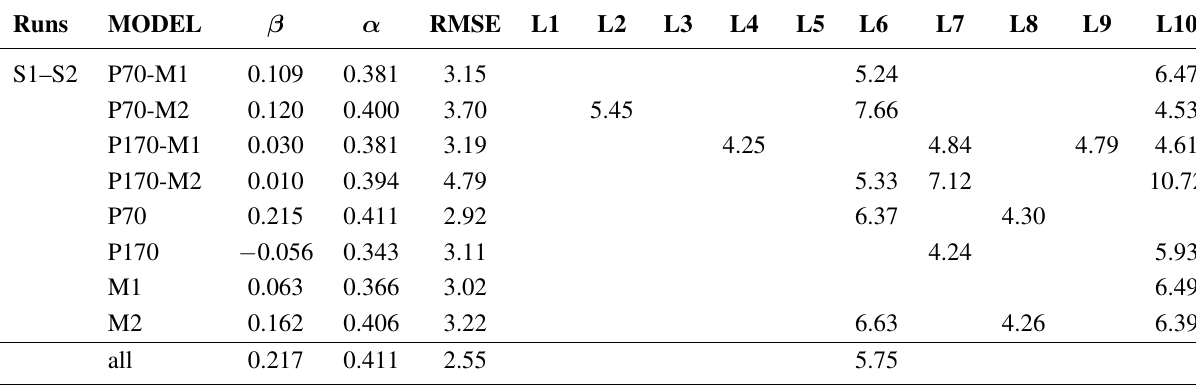
Table 4. α and β parameters for the LIE models obtained from simulation sets S1 and S2, by considering S1 and S2 sets separately in Equation (3). For each LIE model, root-mean-square errors (RMSEs, in kJ mol − 1 ) between calculated ( ∆ G ) and experimental binding free calc energies ( ∆ G ) are shown as well, together with errors (in kJ mol − 1 ) in the prediction exp for the compounds (outliers) for which ∆ G deviates by more than 1 kcal mol − 1 calc (4.184 kJ mol − 1 ) from ∆ G . exp